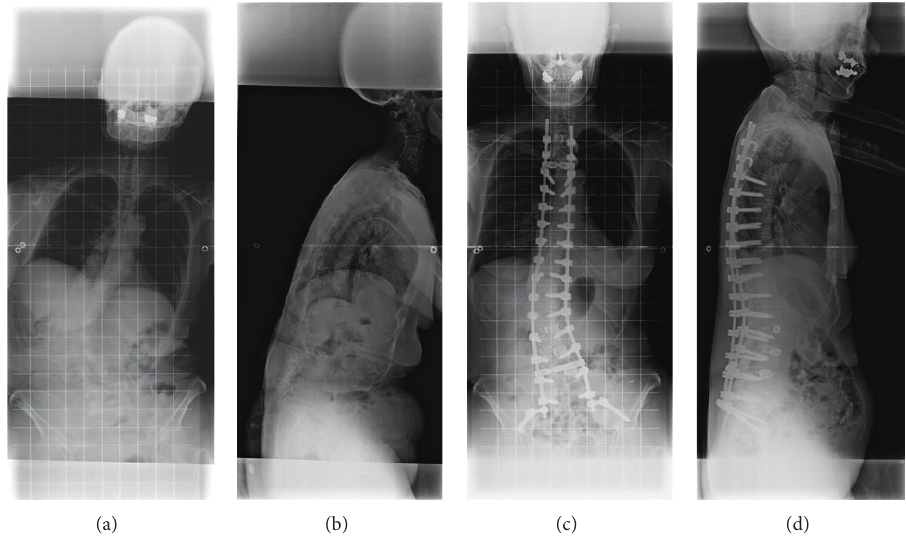
Figure 1: X-ray film images from a 70-year-old woman before and after surgery (Case 1). Anterior-posterior view (a) and lateral view (b) before surgery and anterior-posterior view (c) and lateral view (d) after surgery.